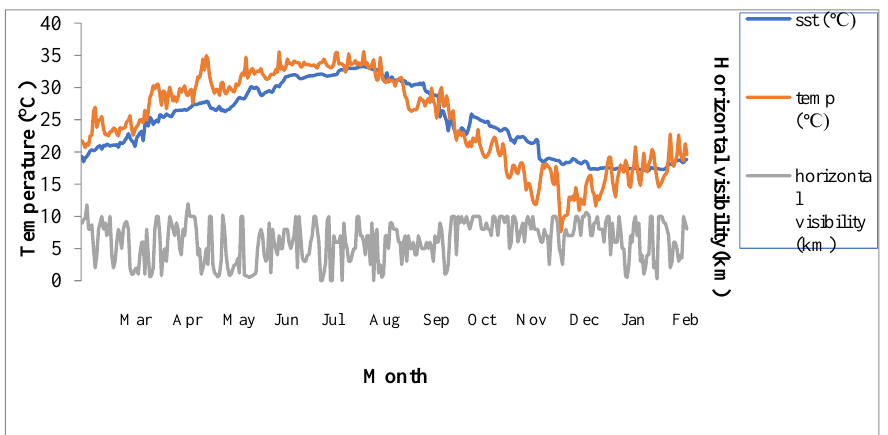
Figure 2. Time series of sea surface temperature, air temperature and horizontal vision in 2008 (sst: Sea surface temperature, temp: Air temperature).